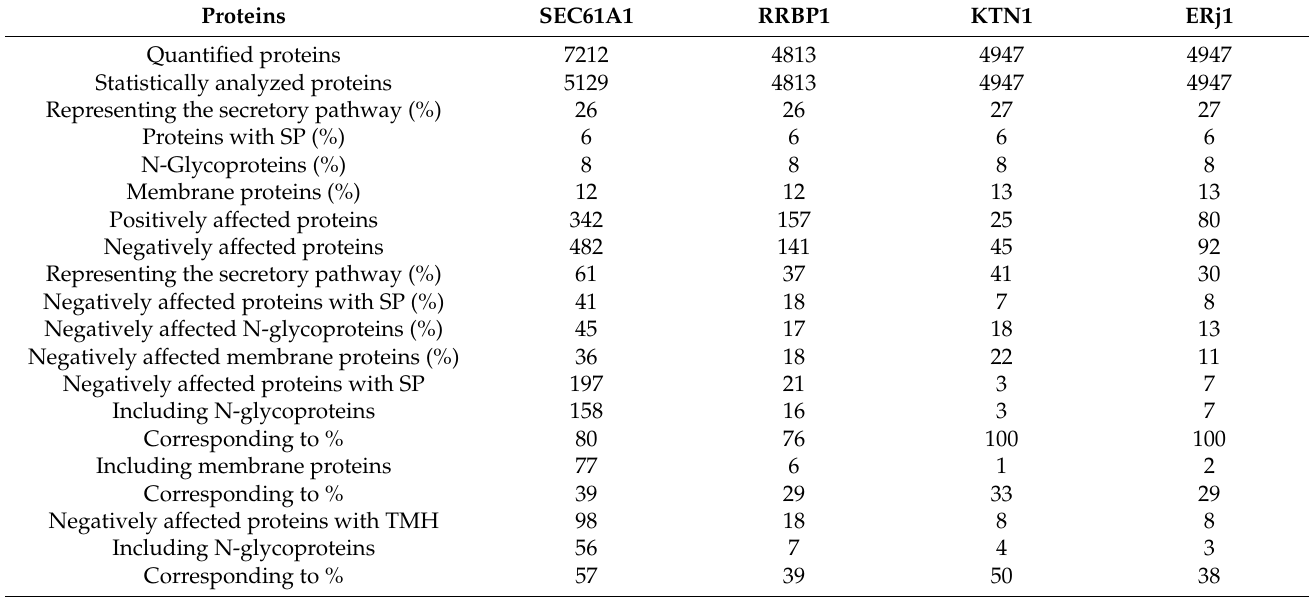
Table 2. Statistics for the identification of RRBP1, KTN1, and ERj1 clients in comparison to Sec61 clients in HeLa